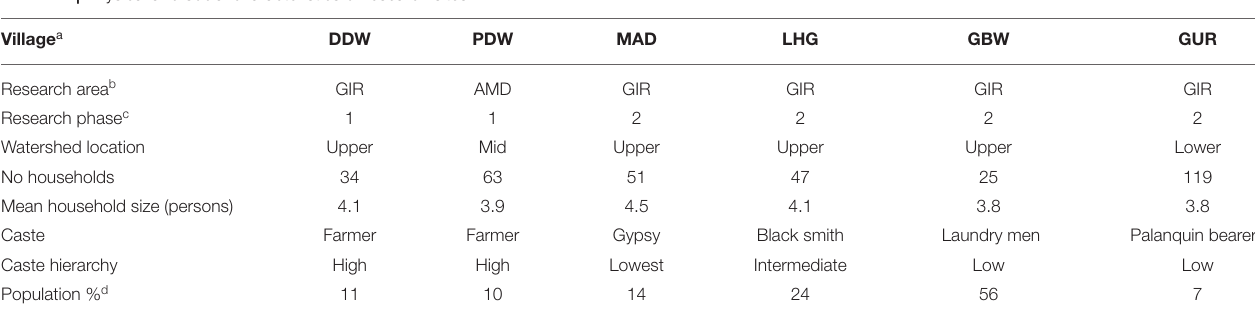
TABLE 1 | Physical and social characteristics of research